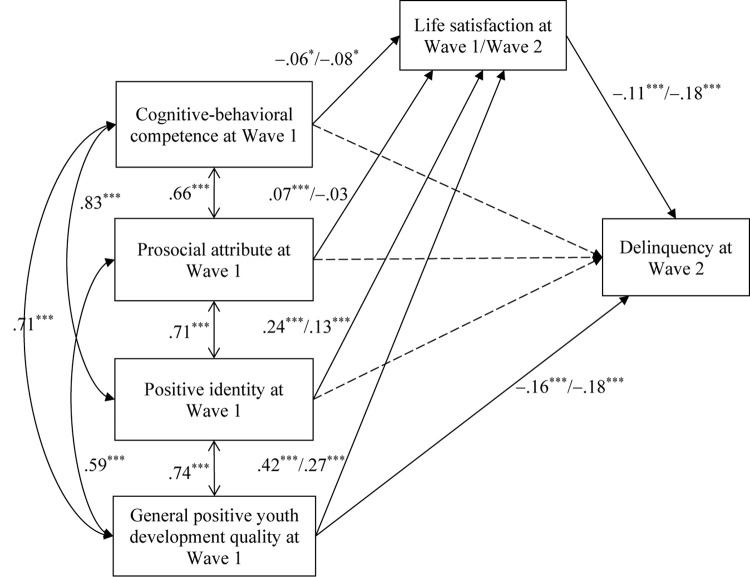
Standardized results of path analyses on the relationships among adolescent positive youth development attributes, life satisfaction, and delinquency. Age, gender, and family intactness were statistically controlled. Numbers before the slash are the results of analysis using life satisfaction at Wave 1 as the mediator and numbers after the slash are the results of analysis using life satisfaction at Wave 2 as the mediator. Solid paths indicate significant associations and dotted paths indicated insignificant associations. ∗p < 0.05, ∗∗∗p < 0.001.